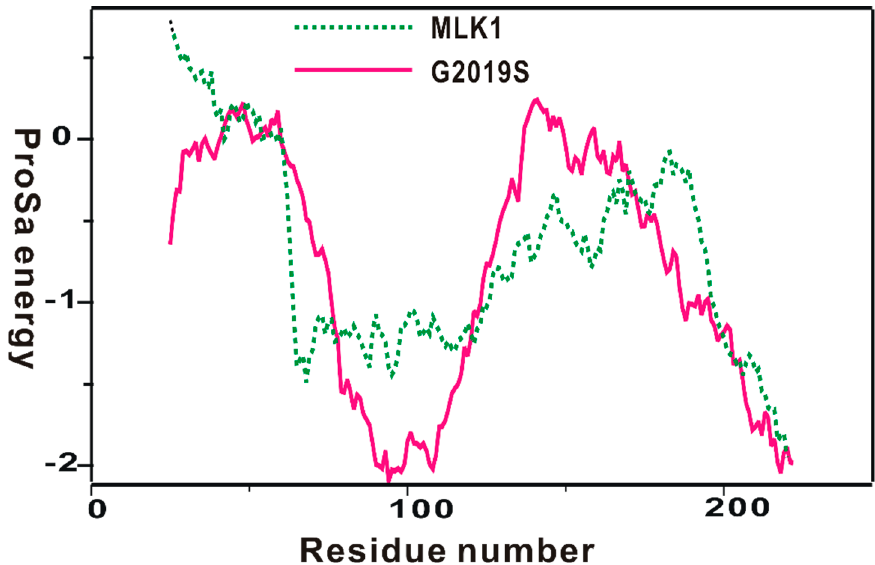
Figure 2. Comparative view of the ProSa energy profile for the homology-modeled structure of the G2019S mutant of LRRK2 and that of the template. The amino acids of the two proteins were renumbered from 1 for convenience.